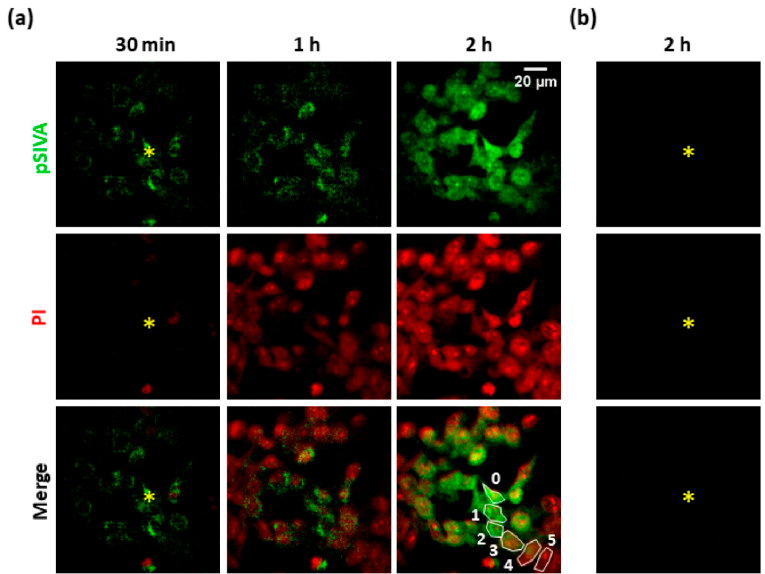
Figure 1. Apoptosis induction in a PS-loaded B16-F10 cell culture exposed to single-cell irradiation. ( a ) The irradiated cell is marked with the yellow asterisk. Time t = 0 corresponds to the end of the photoactivation protocol (SS conditions, see Materials and Methods, Section 2.2). Green fluorescence emission indicates pSIVA-IANBD (pSIVA) probe activation in apoptotic cells; red fluorescence emission indicates propidium iodide (PI), which labels damaged or late apoptotic cells. ( b ) Control experiment performed in a cell culture exposed to single-cell irradiation in the absence of PS. PS: photosensitizer. SS: standard